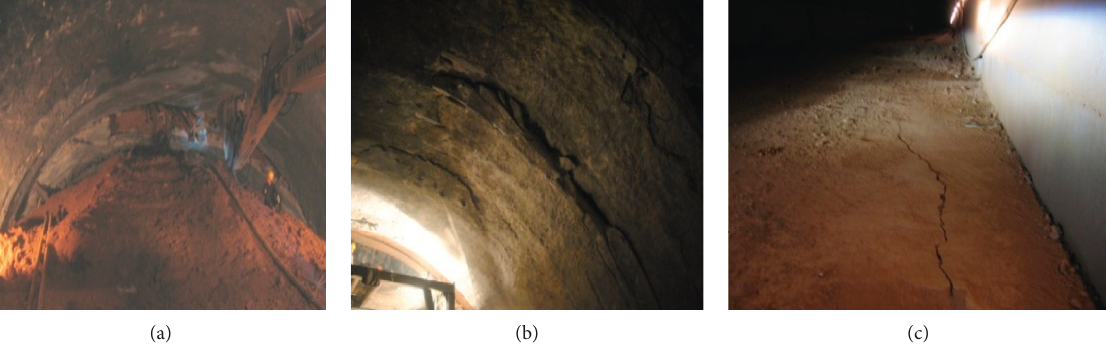
Figure 7: The damage of the water-rich loess tunnel during construction. (a) Collapse of the tunnel face, (b) primary support cracking, and (c) inverted arch